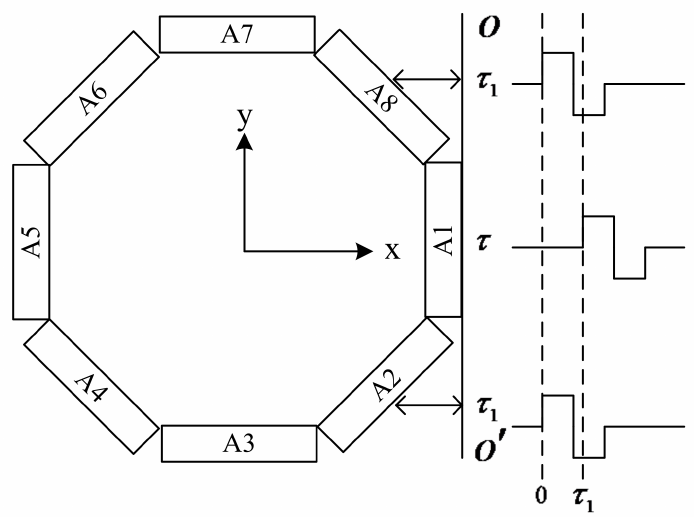
Figure 2. Schematic showing the construction and operational principles of the azimuthal- transmitting arc array.